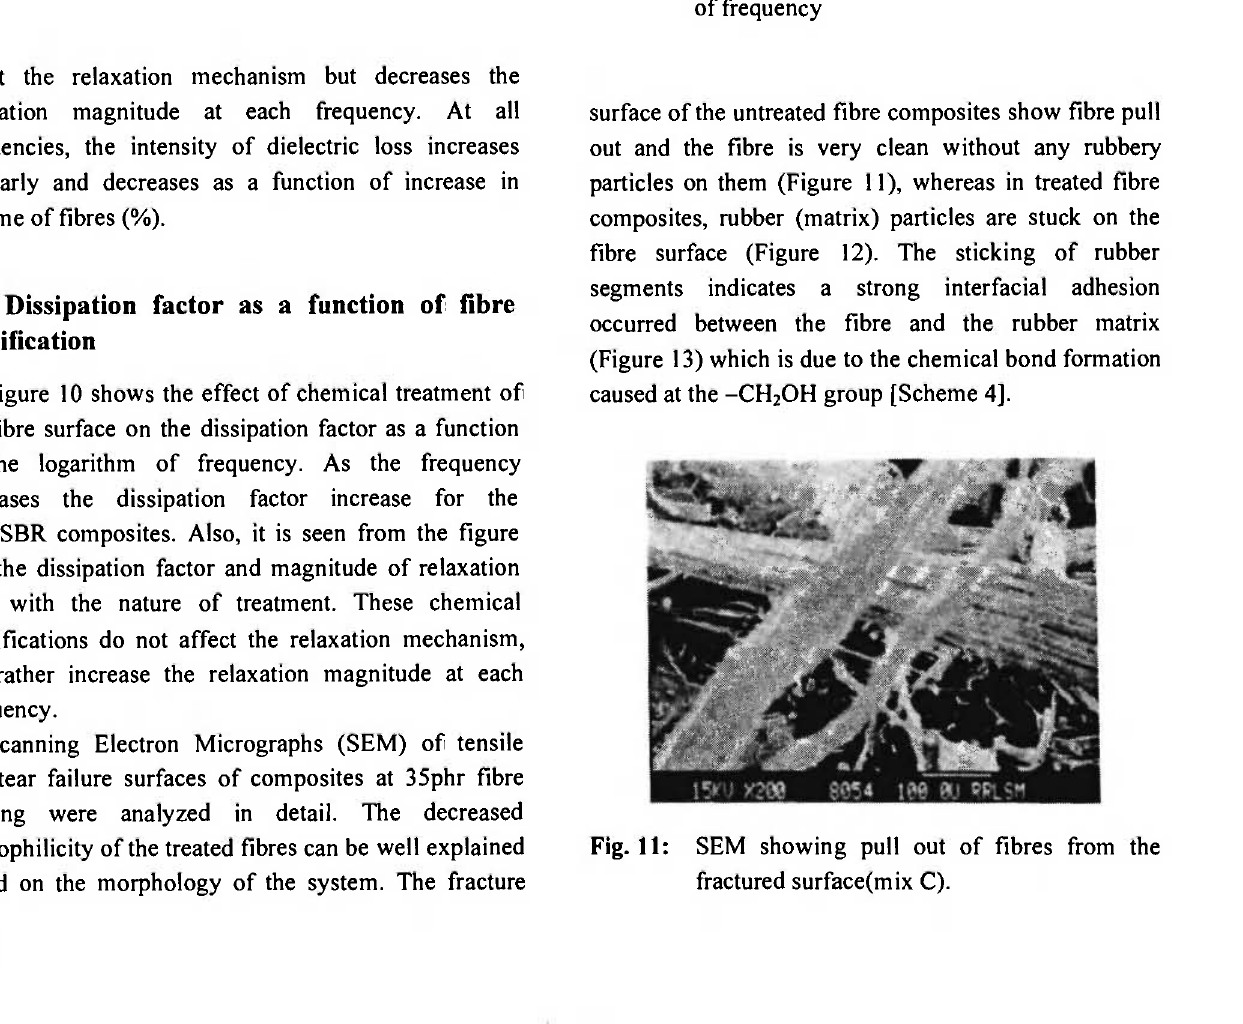
Fig. 9: Effect of volume of fibres on dissipation factor of composites as a function of frequency.